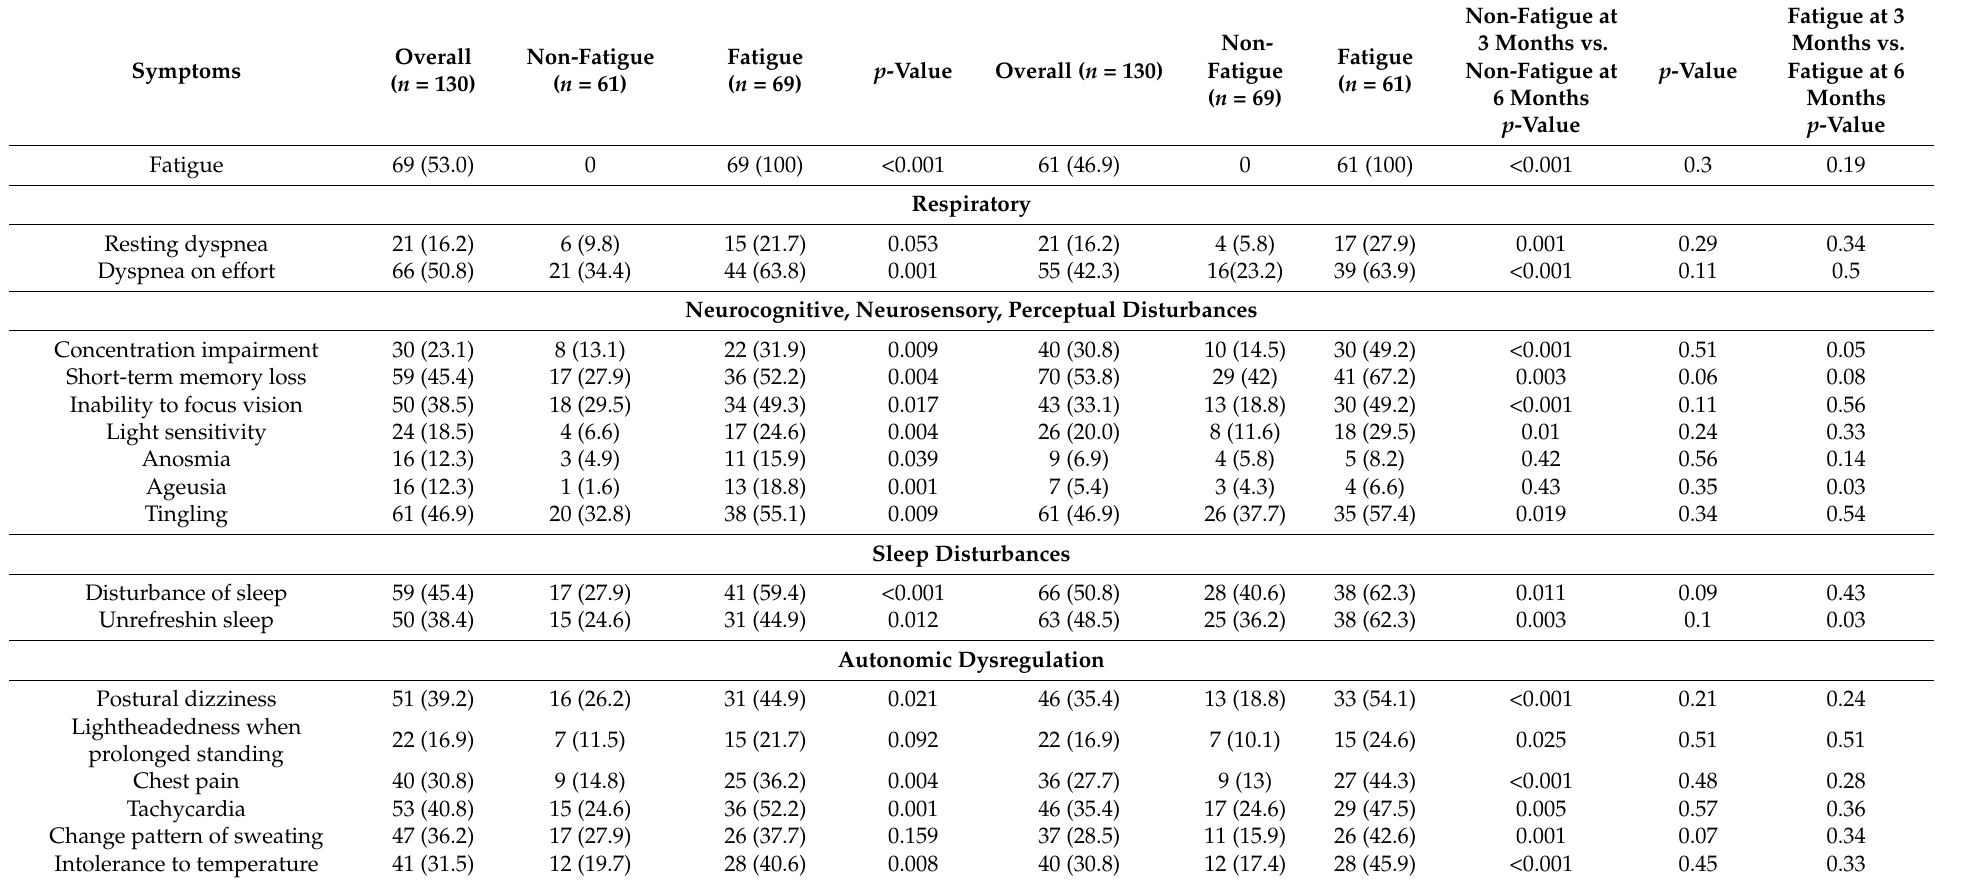
Table 2. Post-acute COVID-19